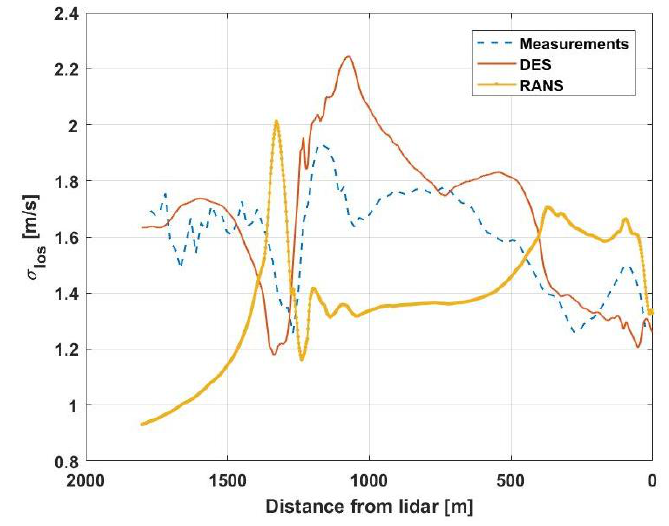
Figure 16. Standard deviation along the Lidar beam averaged for 14 June 2015 1:00 p.m. to 10:30 p.m. estimated by the Lidar and computed with the RANS and DES